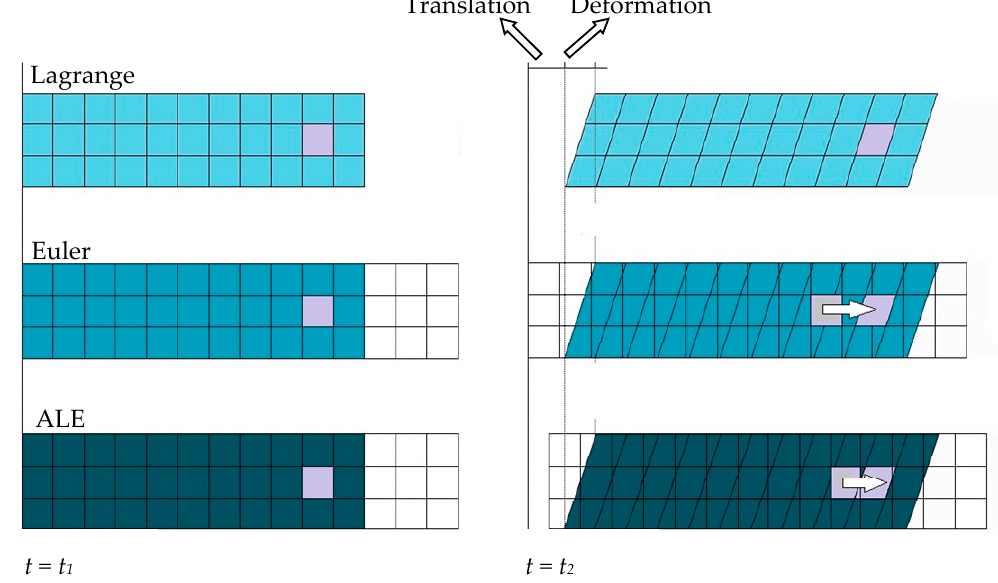
Figure 1. Deference between the Lagrange, Euler and ALE (arbitrary Lagrangian–Eulerian) algorithms .